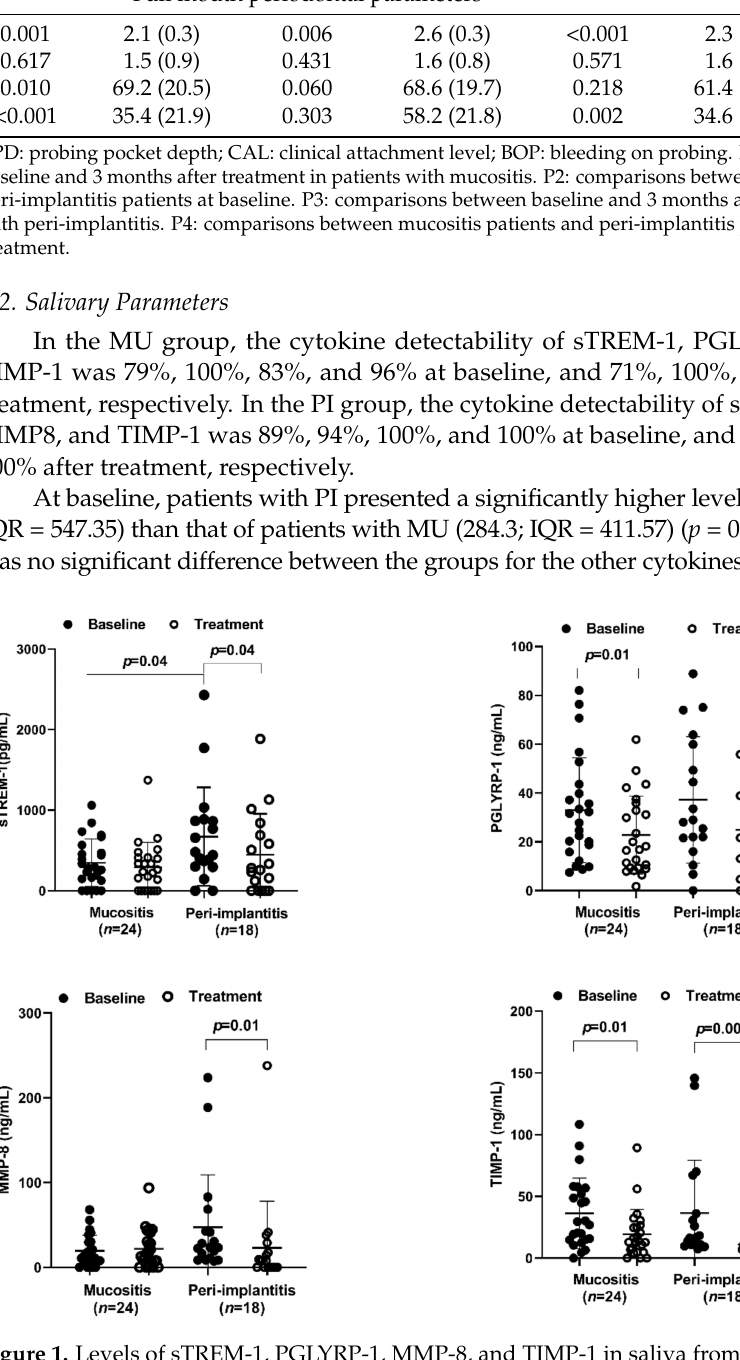
Figure 1. Levels of sTREM-1, PGLYRP-1, MMP-8, and TIMP-1 in saliva from individuals with peri- implant mucositis and peri-implantitis before and after treatment. p ≤ 0.05 (Wilcoxon signed-rank